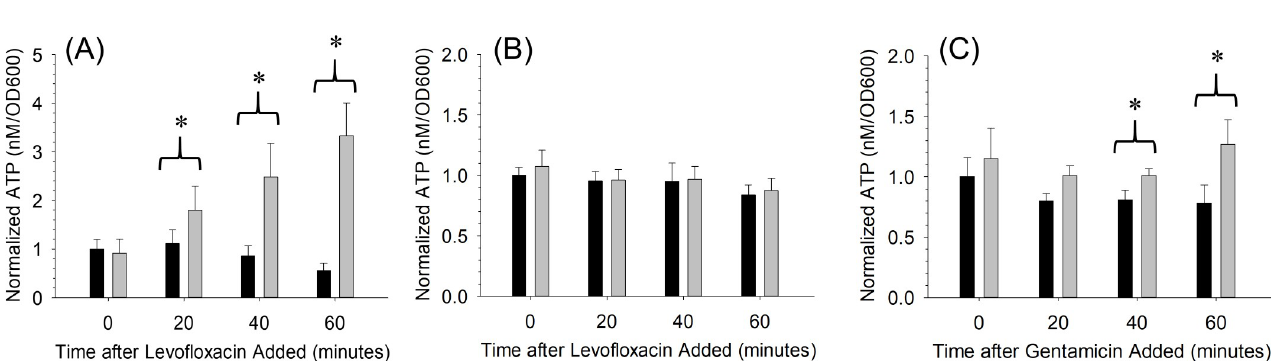
Fig 3. Normalized ATP/OD600 levels showing susceptibility and resistance of E . coli to bactericidal antibiotics. E . coli bacteria were preincubated for 2 hours with the antibiotic kanamycin (50 mg/L, black bars), which permits selective growth, before adding an antibiotic to which the bacteria are susceptible (gray bars). (A) ATP/OD600 levels of kanamycin-resistant E . coli with kanamycin (50 mg/L) versus kanamycin (50 mg/L) and the antibiotic to which the bacteria are susceptible, levofloxacin (5 mg/L). (B) ATP/OD600 levels of kanamycin/levofloxacin-resistant E . coli with kanamycin (50 mg/L) versus kanamycin (50 mg/L) and levofloxacin (5 mg/L). (C) ATP/OD600 levels of kanamycin/levofloxacin-resistant E . coli with kanamycin (50 mg/L) versus kanamycin (50 mg/L) and the antibiotic to which the bacteria are susceptible, gentamicin (6 mg/L). n = 3; error = standard deviation; � p < 0.05.